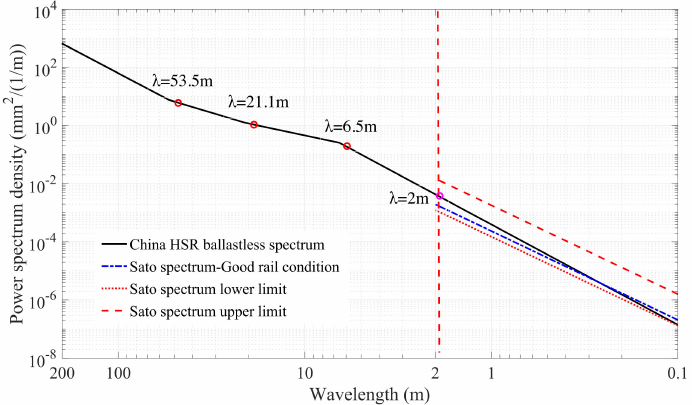
Figure 2. Irregularity spectrum of ballastless track of China’s high-speed